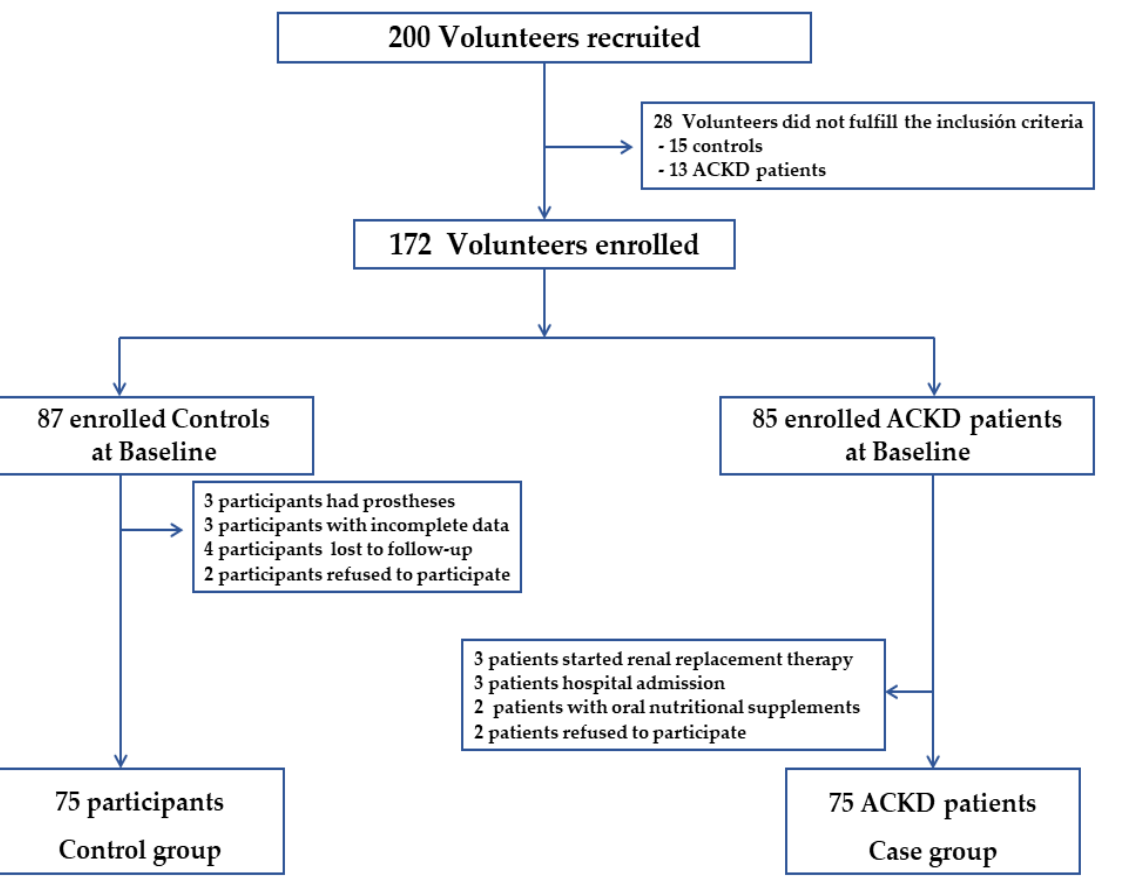
Figure 1. Flowchart of participants who met inclusion and exclusion criteria for the study popula- tion. ACKD, advanced chronic kidney disease.